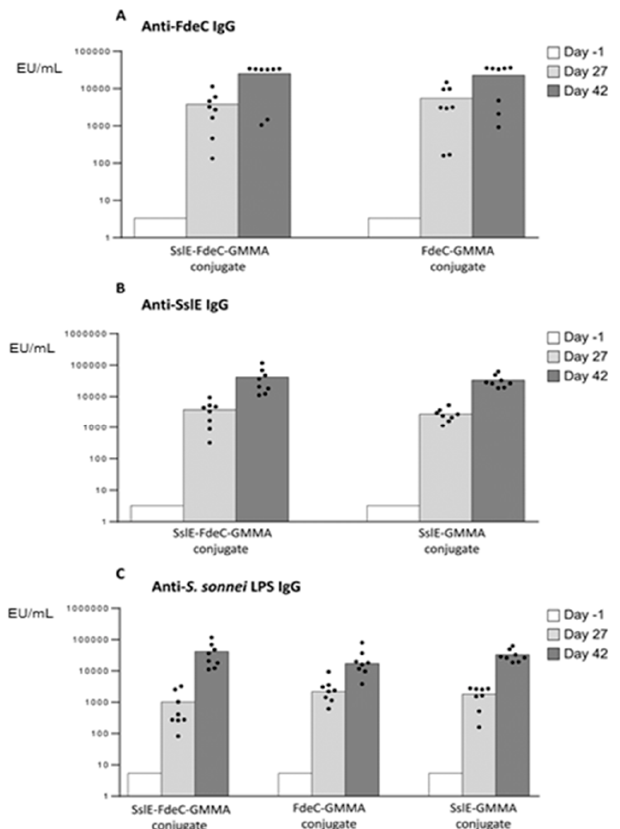
Figure 5. SslE and FdeC presented on the same S. sonnei GMMA particle compared to corresponding monovalent conjugates. Eight CD1 mice per group were i.m. immunized at days 0 and 28, with 5 µg total protein, in the presence of Alhydrogel. Sera were collected at days -1, 27 and 42 and analyzed for anti- E. coli antigen-specific ( A , B ) and anti- S. sonnei LPS ( C ) IgG response. Summary graphs of IgG geometric mean units (bars) and individual antibody levels (dots) are reported. Datasets were analyzed using a two-tailed nonparametric Mann–Whitney test. p -values (rounded to the nearest larger number) less than 0.05 were considered statistically significant.